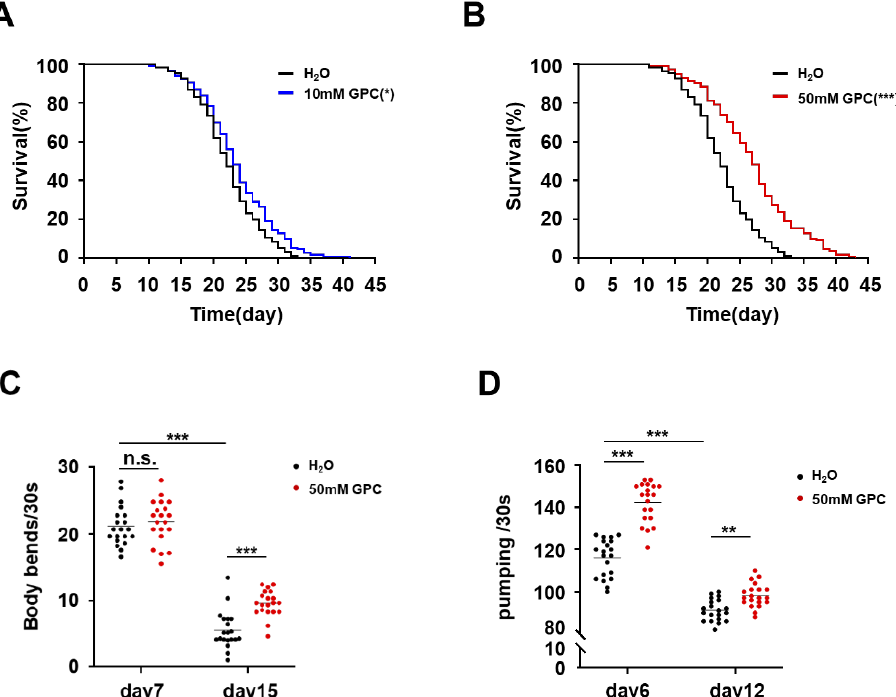
Figure 2. GPC extends lifespan and improves fitness of C. elegans . ( A , B ) Lifespan of worms treated with GPC (10, 50 mM) or vehicle (H 2 O). p values represent comparison with vehicle calculated using long rank test. ( C ) Body bending frequency on days 7 and 15 of adulthood in worms treated with 50 mM GPC or vehicle ( n = 20). ( D ) Pharyngeal pumping frequency on days 6 and 12 of adulthood in worms treated with 50 mM GPC or vehicle ( n = 20). For ( C , D ), ** p ≤ 0.01; *** p ≤ 0.0001; n.s., not significant; by two-way analysis of variance (ANOVA) followed by Bonferroni tests. Values are mean ±